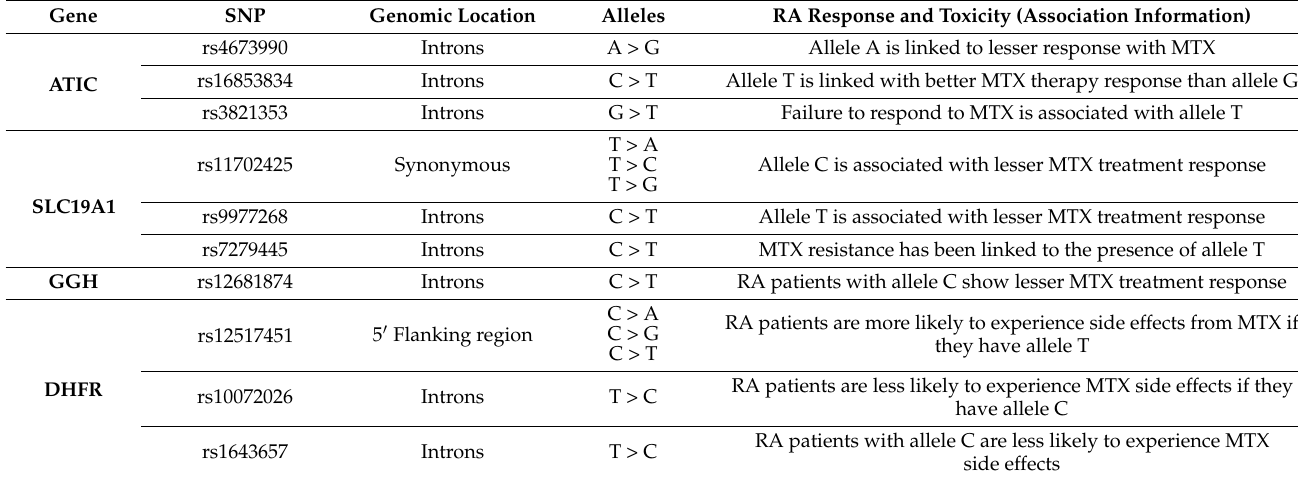
Table 1. Characteristics and consequences of the ten SNPs understudy in MTX pathway and their drug response data from